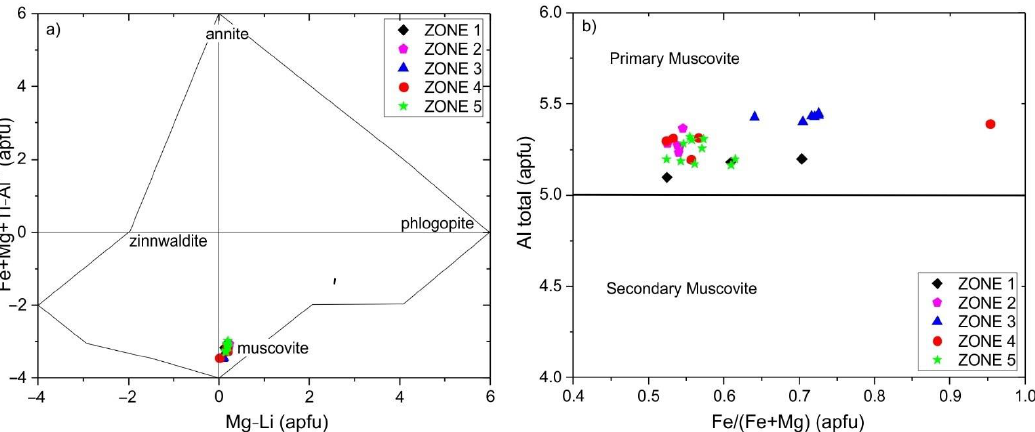
Figure 11. ( a ) Fe+Mg+T-Al VI vs. Mg-Li diagram of mica showing the position of muscovite of Yamrang Pegmatite [41]; ( b ) Total Al (apfu) vs. Fe/(Fe+Mg) diagram of muscovite from Yamrang Pegmatite. The discrimination line of primary and secondary muscovite is from [42]. The K/Rb value ranges from 18 to 140, K/Cs from 199 to 7900, Rb/Sr from 170 to 19,660, and Nb/Ta from 2 to 17 (Table 6). In Figure 12a, the Cs vs. K/Rb plot of muscovite shows an overall negative correlation between K/Rb and Cs, and data points are distributed between Mus-class and REL-class pegmatites. In Figure 12b, the Be vs. K/Rb plot of muscovite shows few data points falling in the REL-class pegmatite field. Muscovites from the miarolitic zone are the most enriched in Be and Cs. The median Be content of muscovite fluctuates less in all zones, ranging from 23 to 30 ppm (Figure 12c). The median muscovite K/Rb and K/Cs value decreases from zones 2 to 5 (Figure 12d,e). The Nb/Ta ratio is highest at zone 3, corresponding to columbite-tantalite mineralization (Figure 12f).